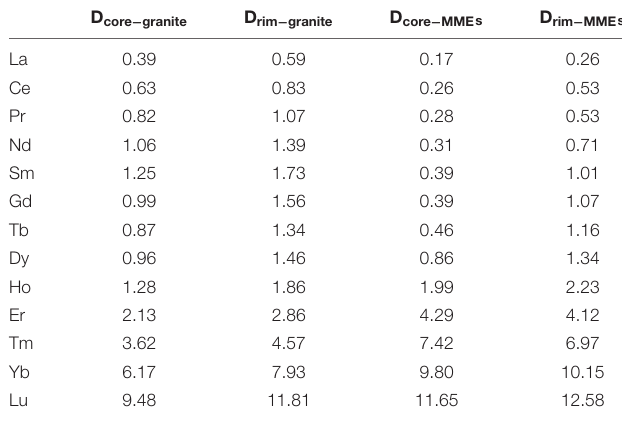
TABLE 5 | Apparent melt-amphiboles partition coefficients (D Amp − bulk ) of rare earth element (REE). D core −